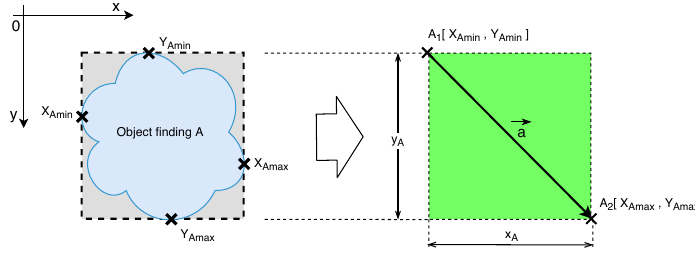
Figure 21. Illustration describing the marking of the object found by a rectangular marking field. The objects found that are thus delimited by the rectangular areas are then checked for intersection with another delimited region in the delimitation area. If they have intersection areas, they are then unified into a common region of the object, as shown in the illustration in Figure